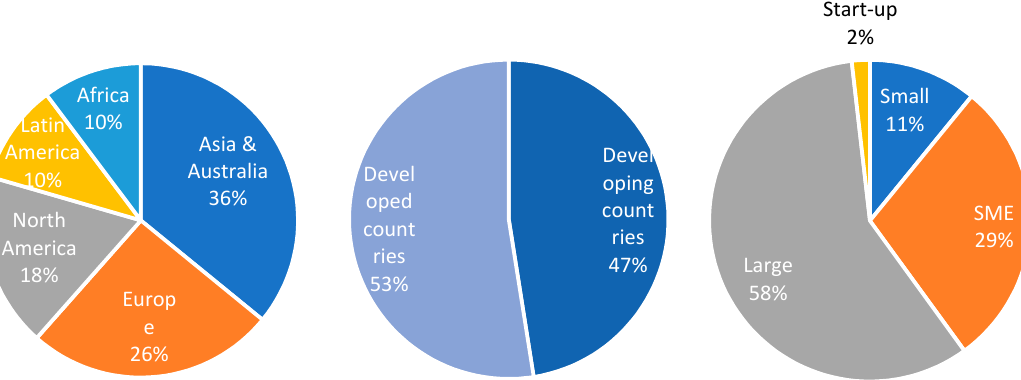
Figure 3. Graphical presentation of the research sample structure.